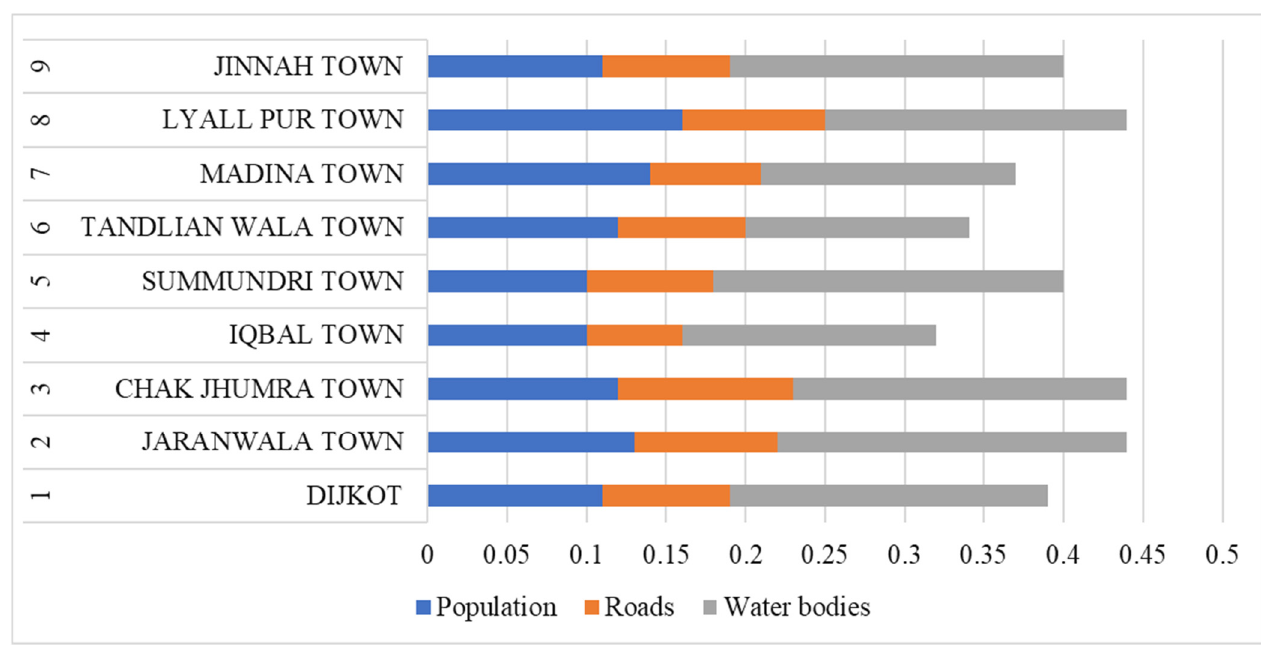
Figure 6. Relative ranked mean of the factors.